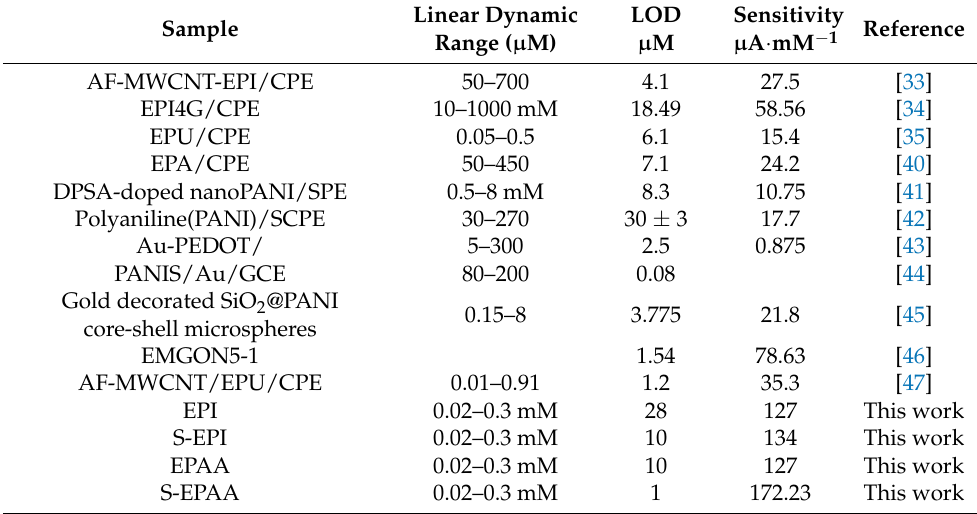
Figure 5. ( a ) Amperometric current responses of EPAA, EPI, S-EPAA and S-EPI-modified CPE electrodes for successive addition of AA into a 30 mL PBS that was stirred constantly. ( b ) Linear calibration curves between the current density and the concentration of AA. Table 1. A comparison of various types of ascorbic acid sensors.